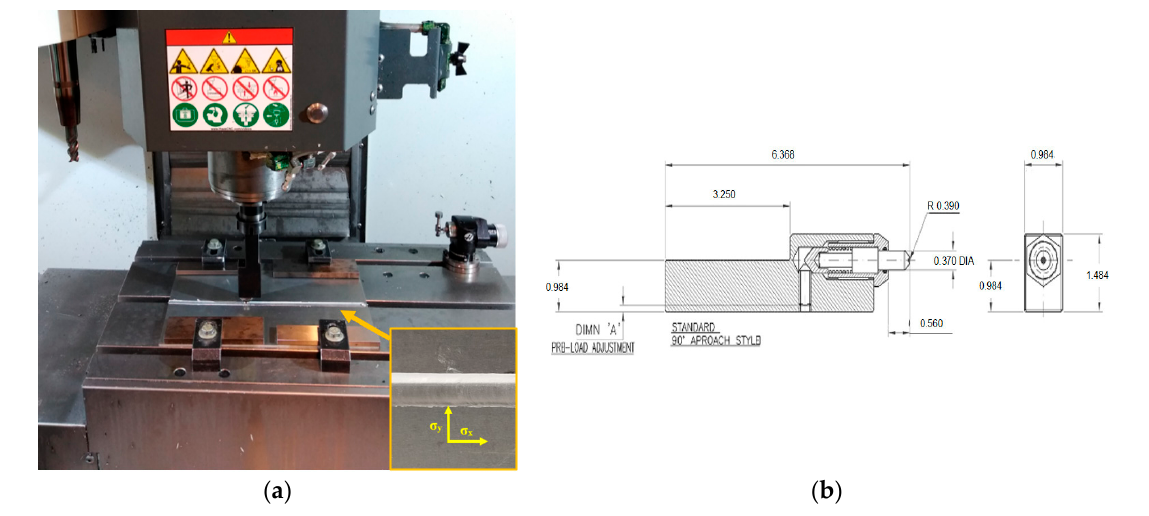
Figure 2. Slide diamond burnishing process ( a ) and burnishing tool ( b ). Table 3. The burnishing parameters used in research according to PS/DC 3 2 . Input Factors Force Burnishing P , N Feed Rate f , mm/min the minimum ( − ) 40 the central (0) the maximum